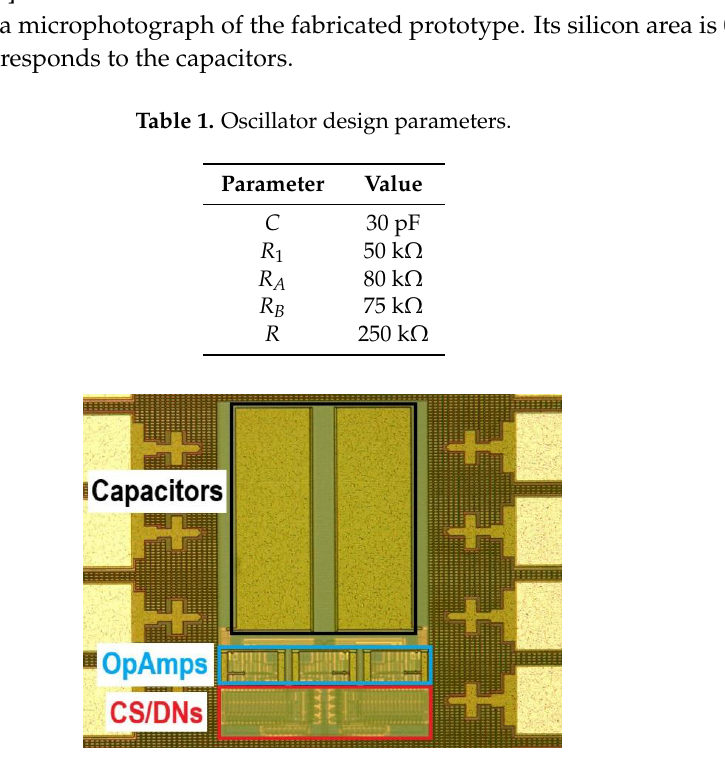
Figure 6. Quadrature oscillator prototype (active area: 283 µm × 455 µm).